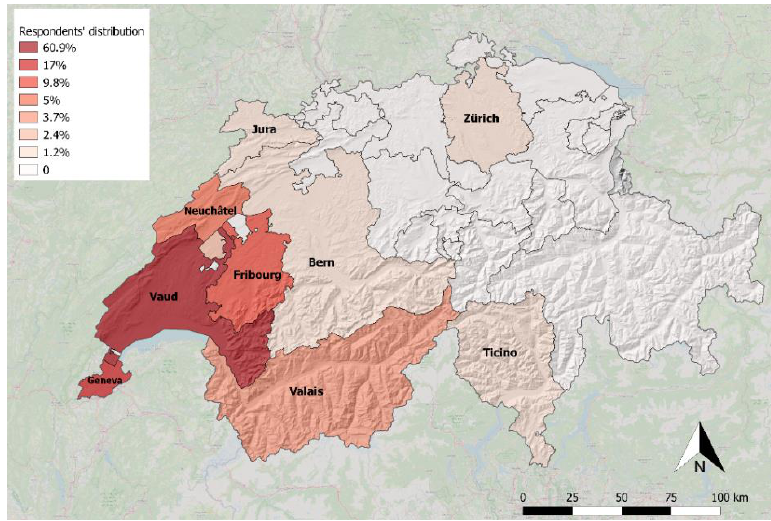
Figure 7. Distribution of BioPocket survey respondents within Switzerland. The regions with no responses are not labelled on the map.